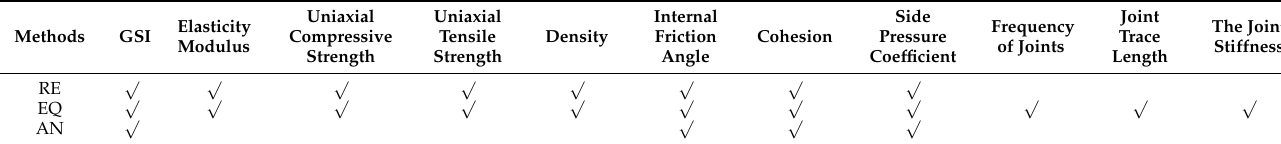
Table 7. Calculation parameters to be obtained by various